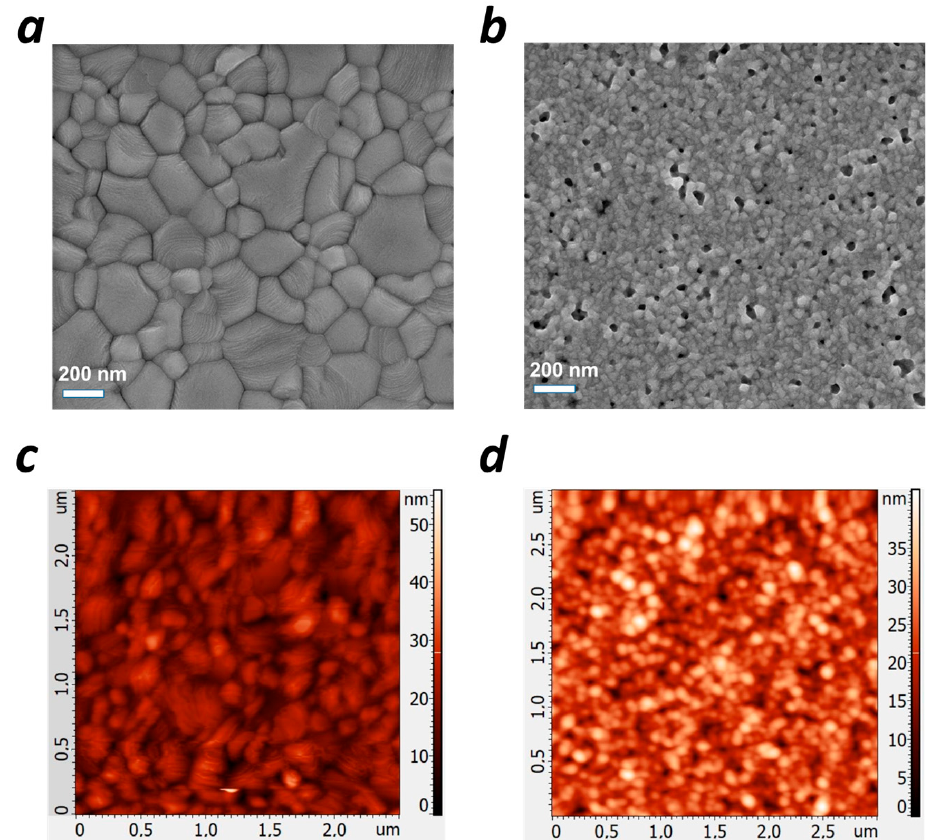
Figure 1. ( a , b ) SEM and ( c , d ) AFM images of ( a , c ) MAPbI 3 and ( b , d ) NAd 2 MA 39 Pb 40 I 119 Cl 2 films. The spin-coated MAPbI 3 and NAd 2 MA 39 Pb 40 I 119 Cl 2 films were transferred to another glove box with integrated aging setups without any contact with ambient oxygen and moisture. The samples were subjected to continuous light soaking using LED-generated white light with a power of ~100 mW/cm 2 under a pure nitrogen atmosphere (O 2 and H 2 O levels of <1 ppm). Half of each sample was protected by black and chemically inert plastic, so heat became the main stress factor for the shaded parts of the samples. The stabilized temperature on the surface of the samples in the aging chamber was 40 ± 4 °C. A more detailed description of the experimental setup can be found in our previous reports [46,47].